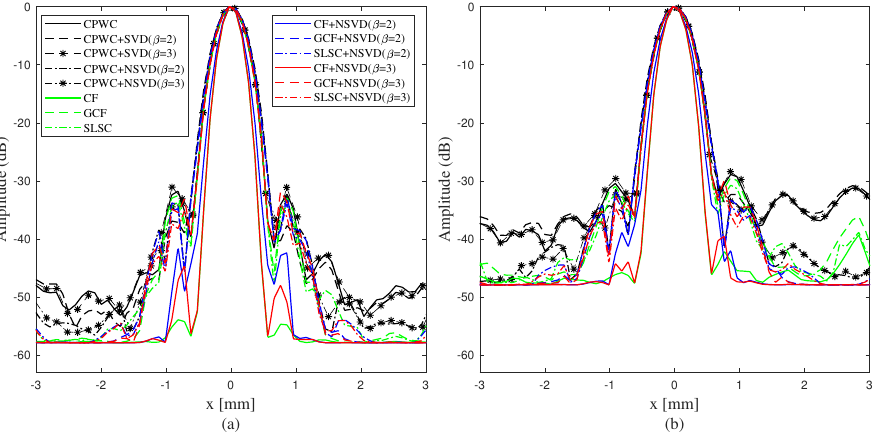
Figure 3. The lateral profiles of two simulated point targets of ( a ) p 1 ( x , z ) = ( 0 mm, 20 mm), ( b ) p 2 ( x , z ) = ( 0 mm, 40 mm).